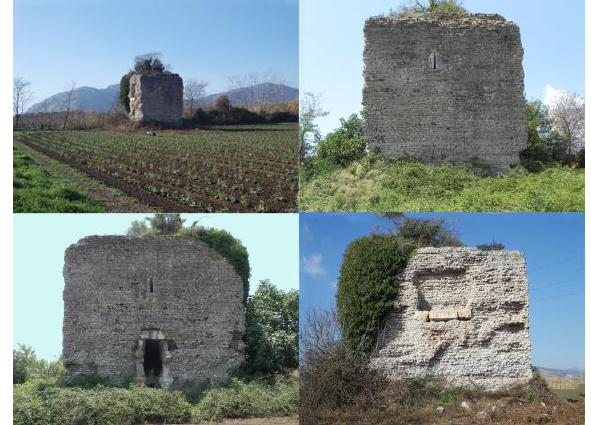
Figure 1. Ruins of the mausoleum ‘Torre del Ballerino’.